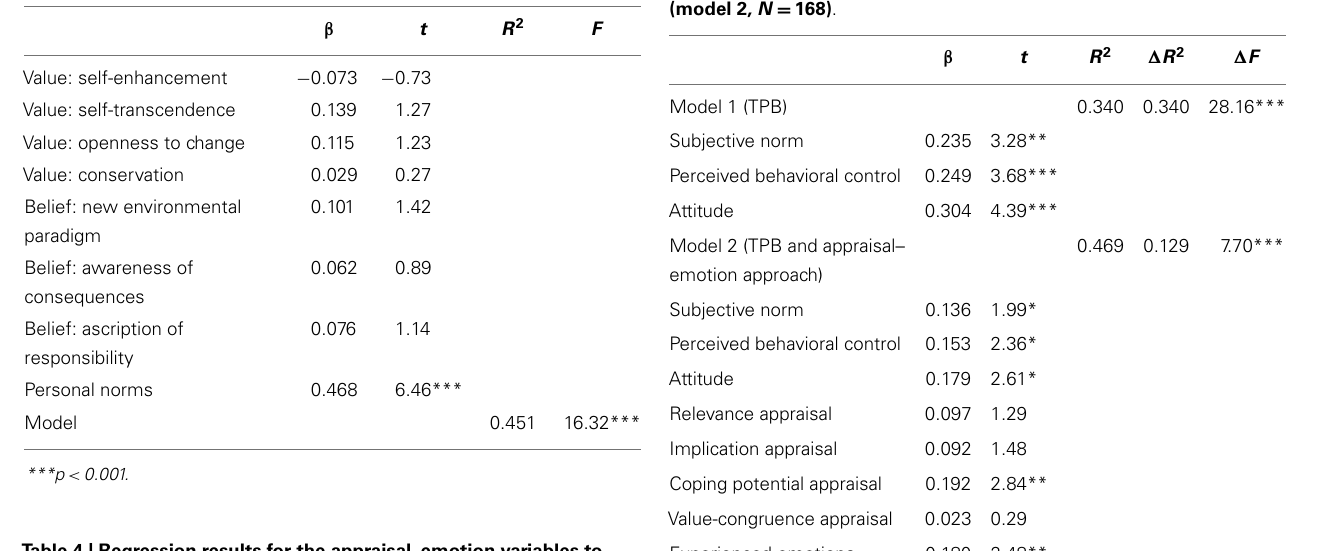
Table 3 | Regression results for theVBN variables to predict intentions to engage in energy-saving behavior ( N = 168) .